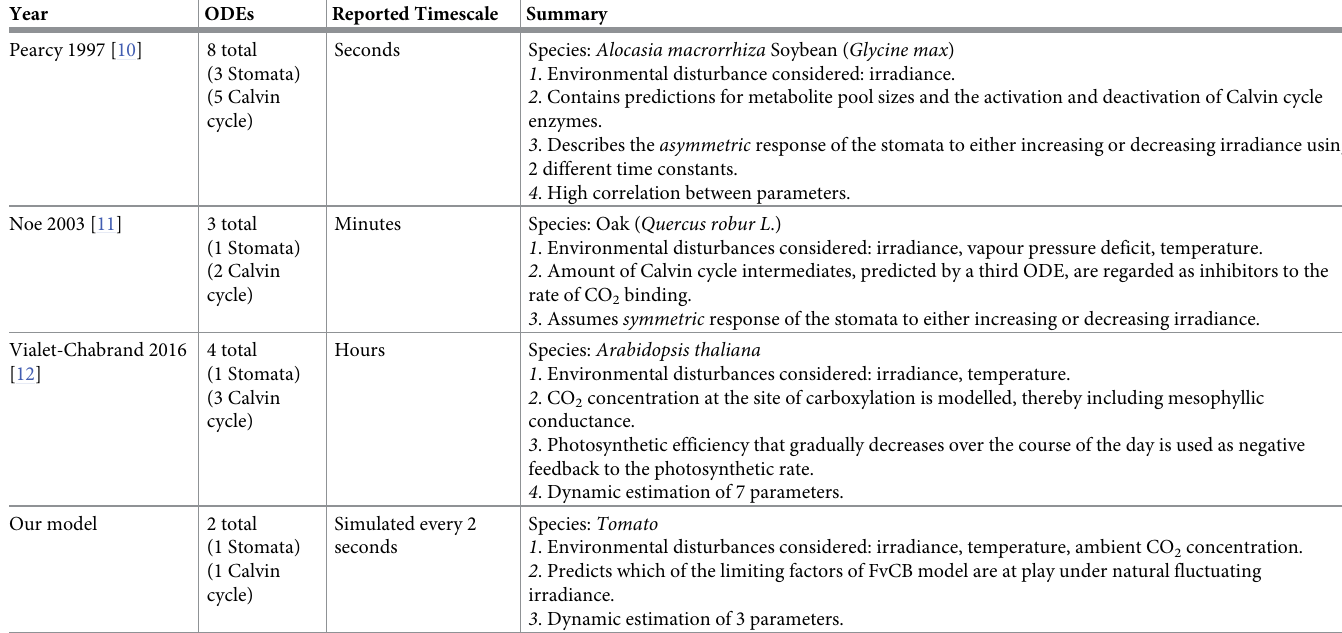
Table 1. Summary of selected small dynamic leaf-level photosynthesis models. (Ordinary differential equations abbreviated as